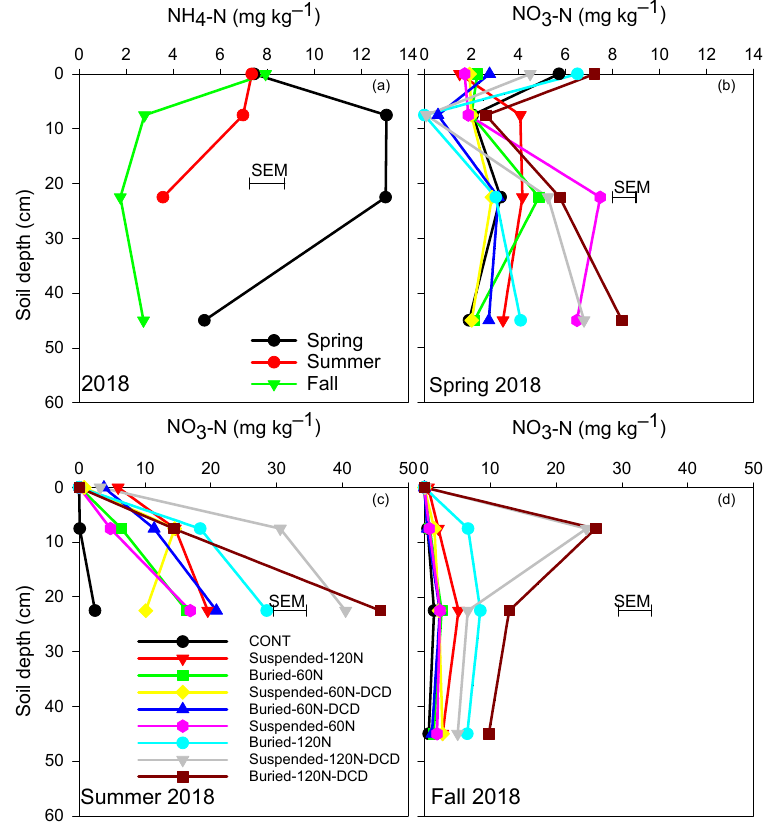
Figure 4. Concentrations of ( a ) ammonium nitrogen (NH 4 -N, mg kg − 1 ) and ( b – d ) nitrate nitrogen (NO 3 -N, mg kg − 1 ) among treatment combinations and soil depth with annual applications of combination of nitrogen fertilizer rates and nitrification inhibitors (2-chloro-6-(trichloromethyl)- pyridine (Nitra-pyrin), di-cycandiamide (DCD)) in soils collected in a long-term blueberry